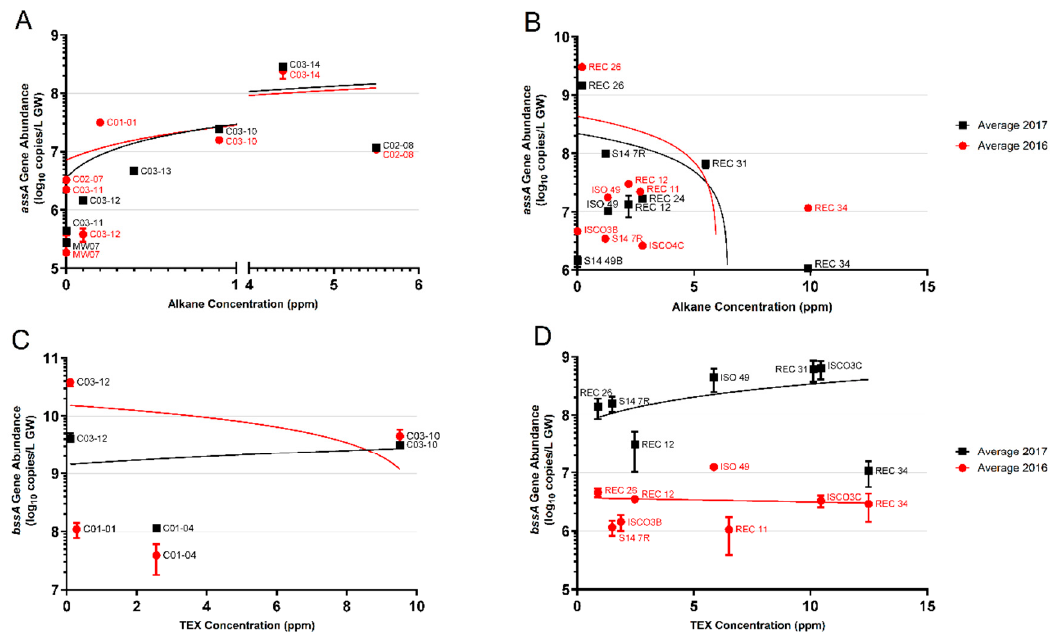
Figure 5. Quantifications of the assA and bssA genes in Sites A and B across 2 years (2016, red circles; 2017, black squares), plotted as a function of alkane or TEX (toluene, ethylbenzene, and xylene) concentrations, respectively. ( A ) assA gene abundances in Site A wells; ( B ) assA gene abundances in Site B wells; ( C ) bssA gene abundances in Site A wells; ( D ) bssA gene abundances in Site B wells. Linear regression trend lines are matched in colour. Only those samples whose amplicons matched the length of standard amplicons are plotted. Error bars represent the standard deviation of technical replicates ( n = 3).